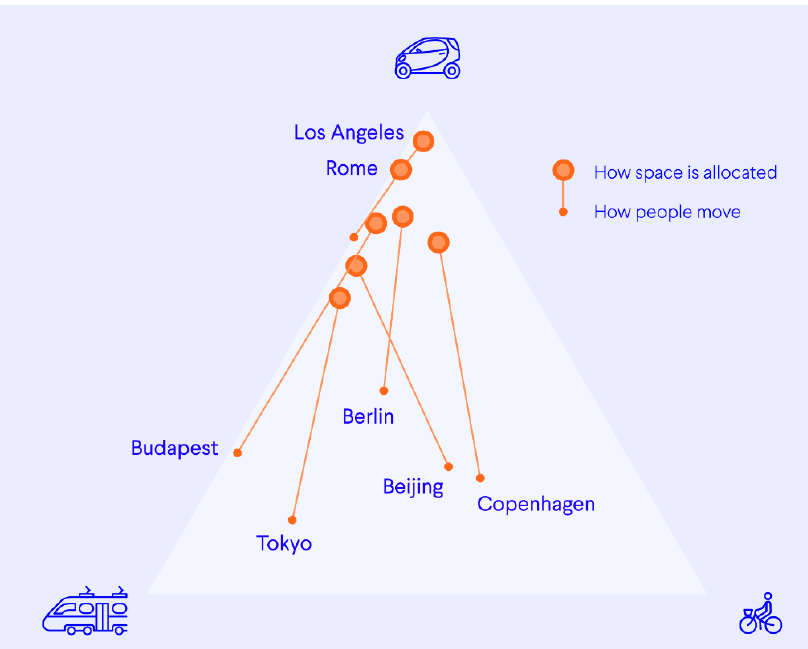
Figure 4. The mobility triangle expresses visually the discrepancy between mobility space distribution (“How space is allo- cated”) and modal share (“How people move”) as a connected pair of dots in a ternary plot, shown for seven selected